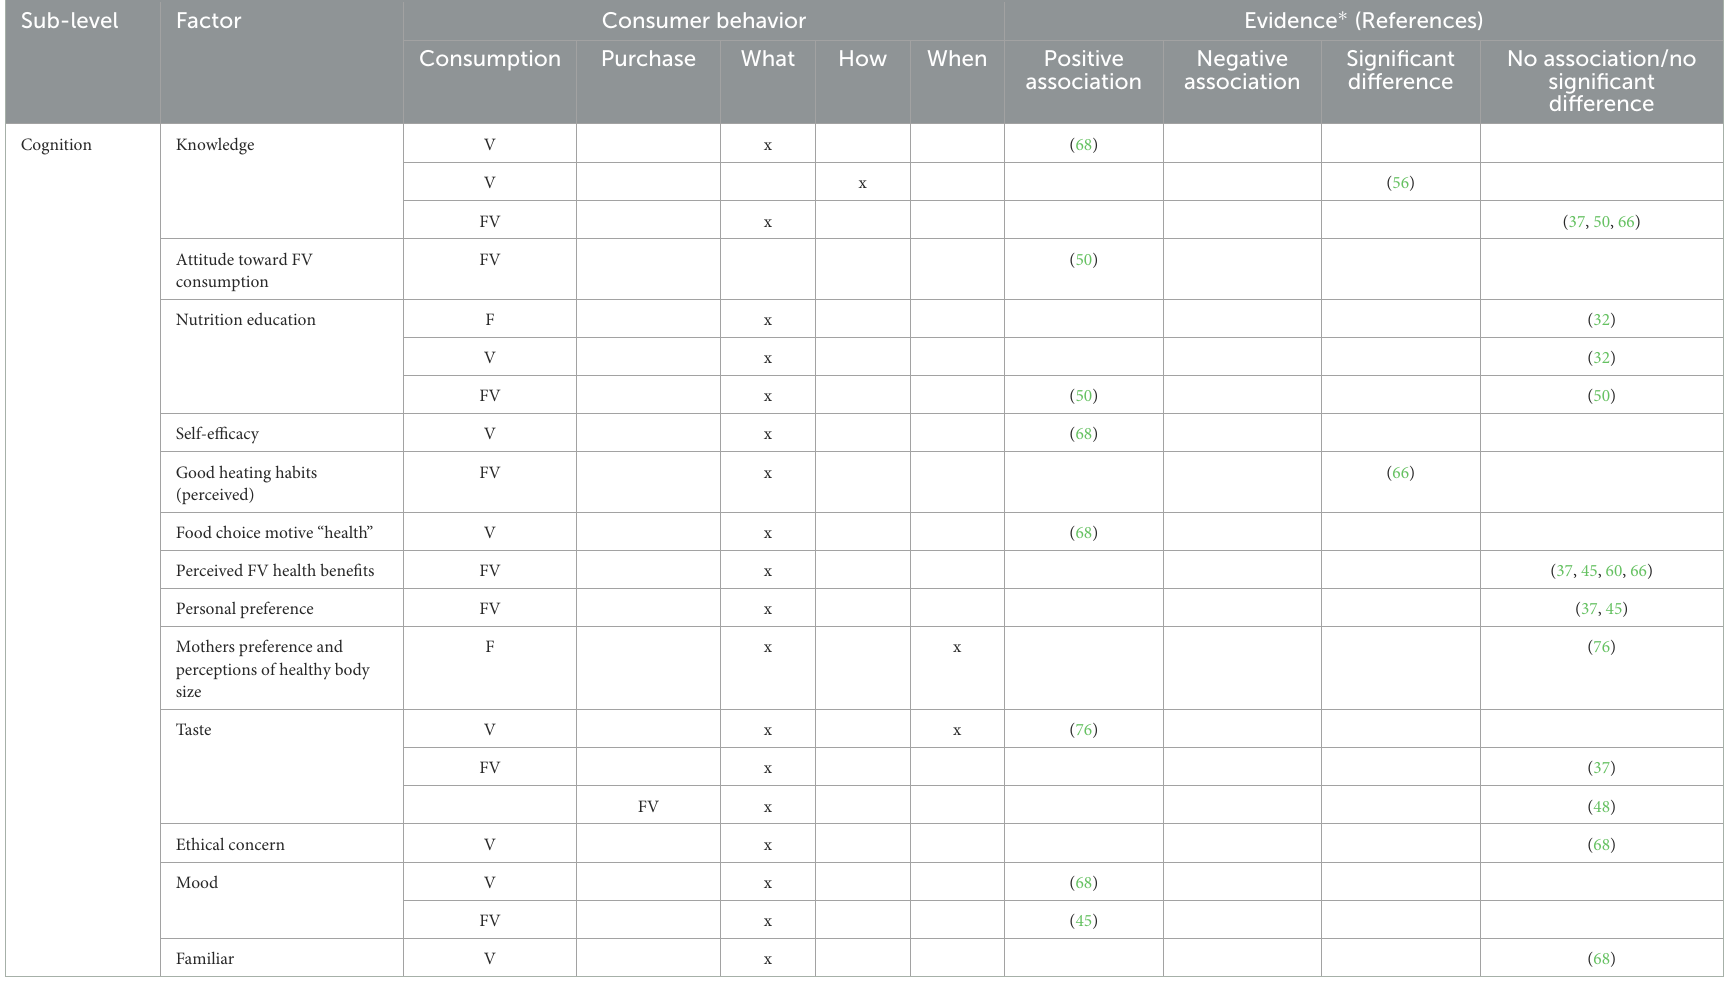
TABLE 2D Individual/household level